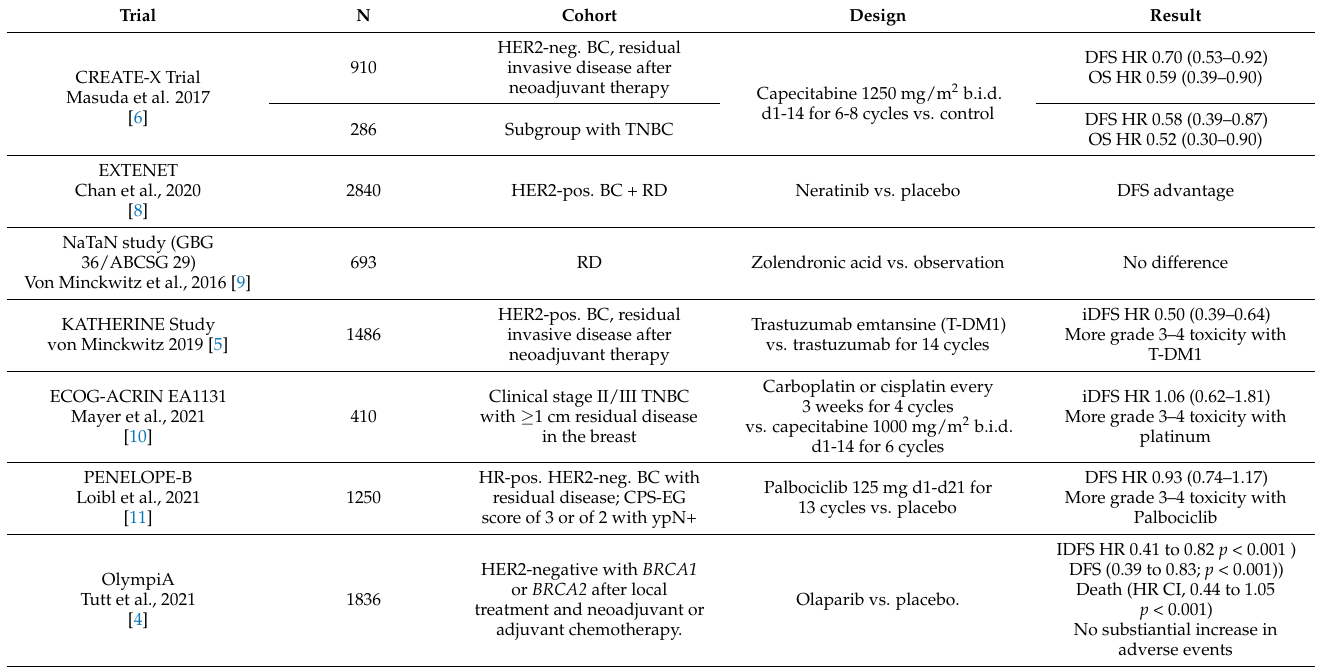
Table 1. Important trials of post-neoadjuvant therapy (Only phase III trials are